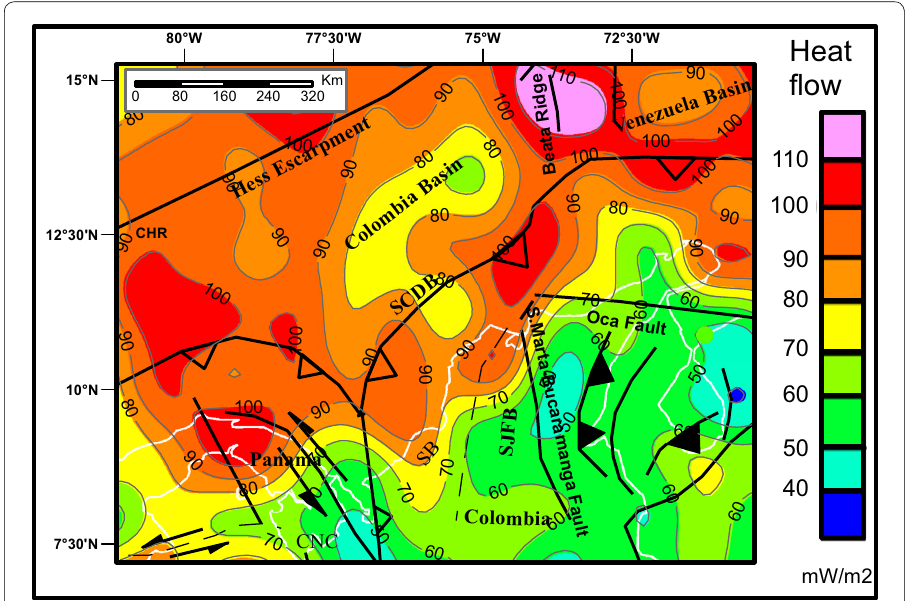
Fig. 10 Heat Flow Map for the Colombian Caribbean. The cold tones correspond to low heat flow (onshore zone) and the warm tones correspond to high heat flow (offshore zone). Tectonic frame as that of Fig.